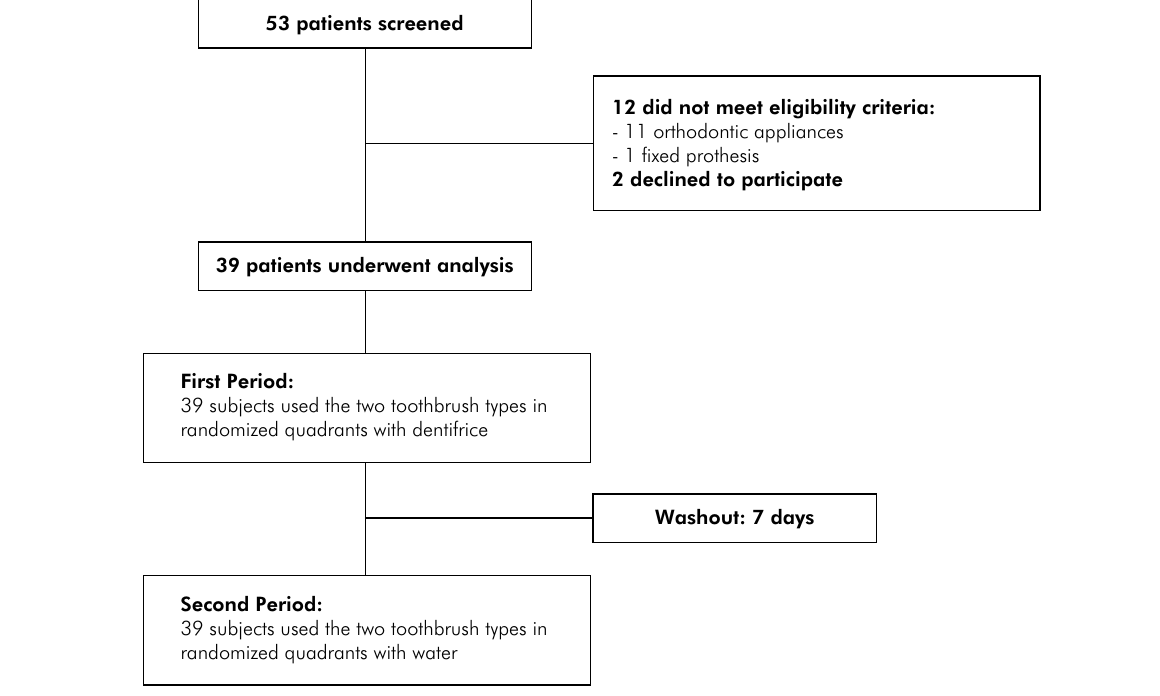
Figure 2. Flowchart of the study